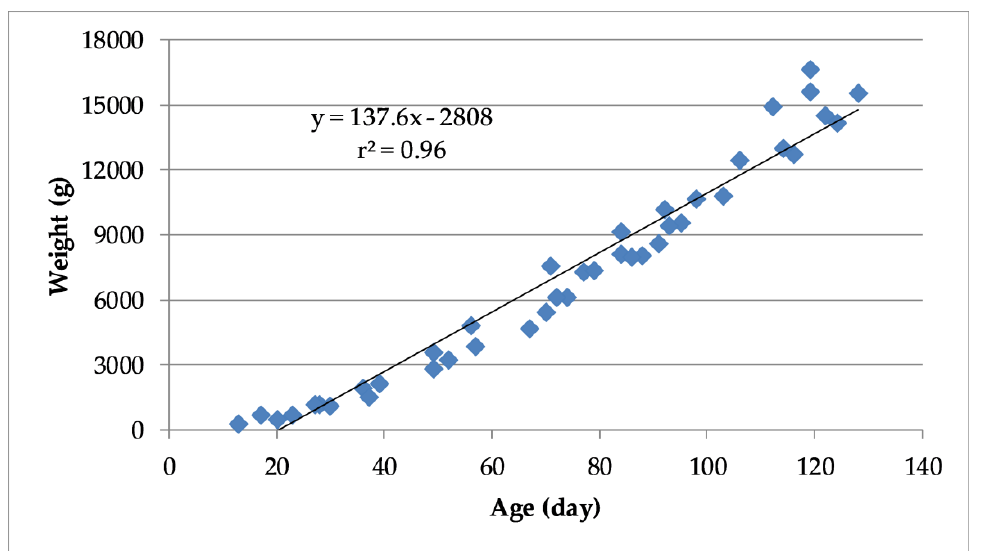
Figure 7. Linear regression and coefficient of determination between turkey weight and age based on pooled data from all trials.